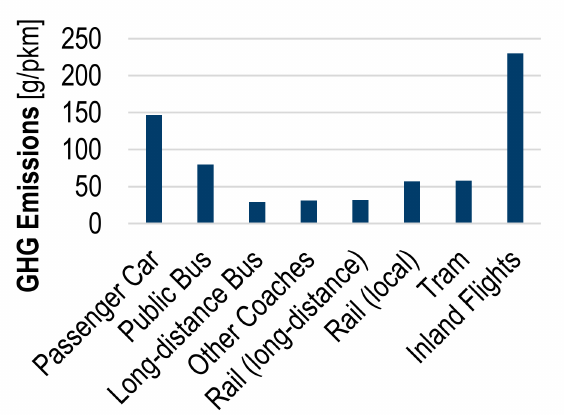
Figure 4. Comparison of average GHG emissions for passenger transport modes in Germany 2018 (based on